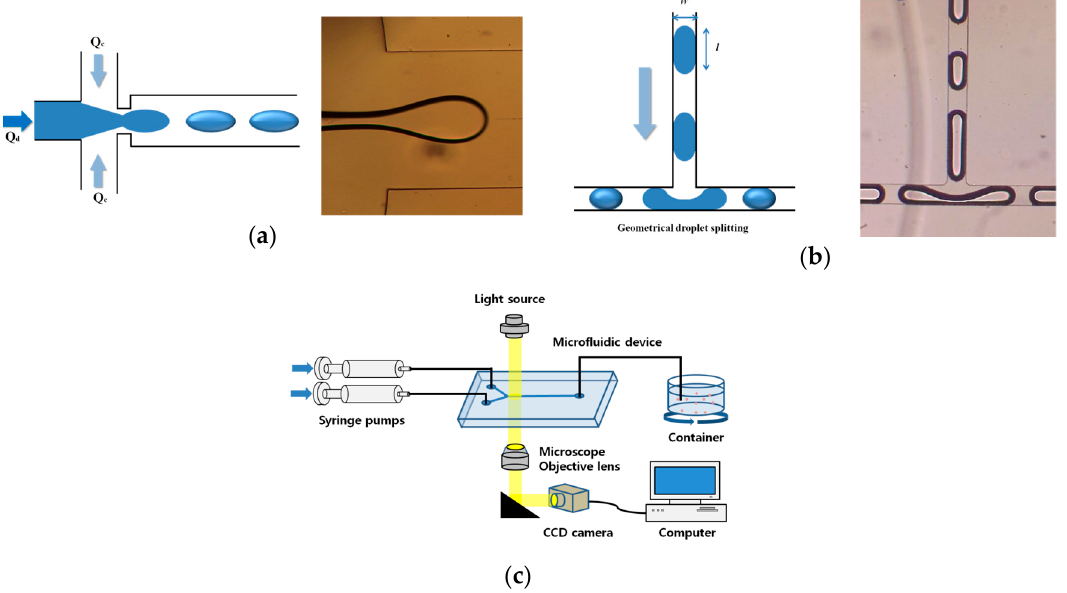
Figure 1. Schematics of ( a ) the flow-focusing part of the inlet and ( b ) droplet splitting at a T-junction in a microchannel in the 512-channel geometrical passive breakup device. ( c ) Experimental set-up for evaluating the microfluidic device ( Q d : dispersed phase; Q c : continuous phase).